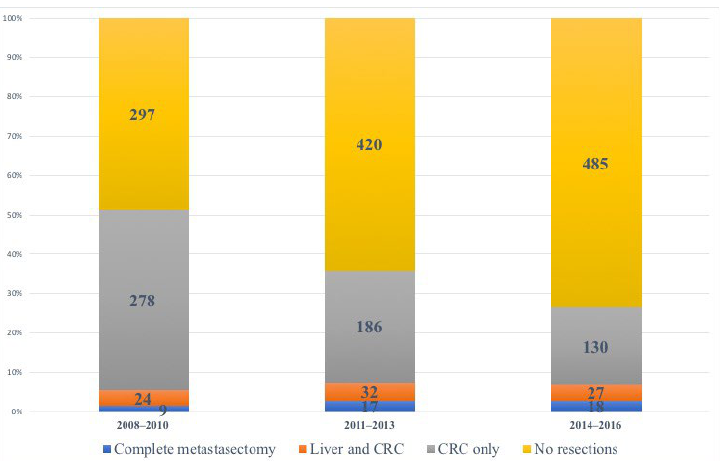
Figure 3. Treatment trends over time. Bar chart illustrating different treatment strategies in different time periods; 2008–2010 ( n = 608), 2011–2013 ( n = 655), and 2014–2016 ( n = 660). Complete metas- tasectomy was conducted in 9 patients (1.5%) in the first time period, 17 patients (2.6%) in the middle time period and 18 patients (2.7%) in the last time period of the study. The proportion of patients having resection of the primary tumor only, in the presence of synchronous liver and lung metasta- ses, significantly decreased over time from 46% (2008–2010) to 28% (2011–2013) and finally 20% (2014–2016), log-rank test p < 0.001. CRC, colorectal.